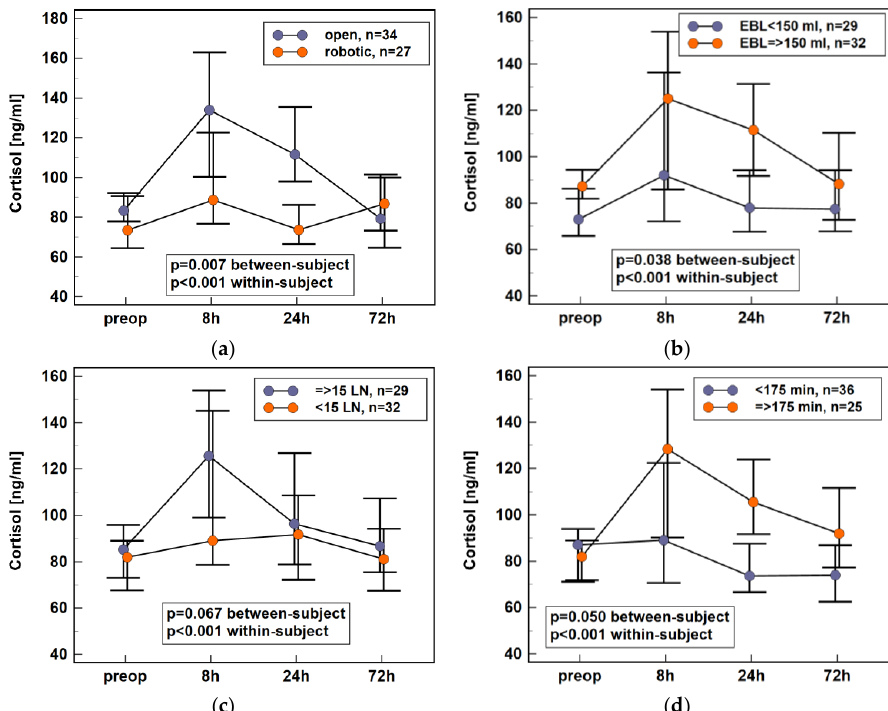
Figure 3. Impact of surgery-related data on plasma cortisol dynamics in early postoperative period following colorectal surgery: ( a ) surgery type; ( b ) estimated blood loss; ( c ) number of harvested lymph nodes; ( d ) length of surgery. Data presented as medians with 95% CI. Data were analyzed following log-transformation using repeated measures analysis of variance with p values indicating significance of between-subjects (surgery type, extent, length, and EBL) and within-subjects (time points) effects ( n = 61). EBL, estimated blood loss; LN, lymph nodes; CI, confidence interval; preop, preoperative; 8h, 8 h post-incision; 24 h, 24 h post-incision; 72 h, 72 h post-incision.